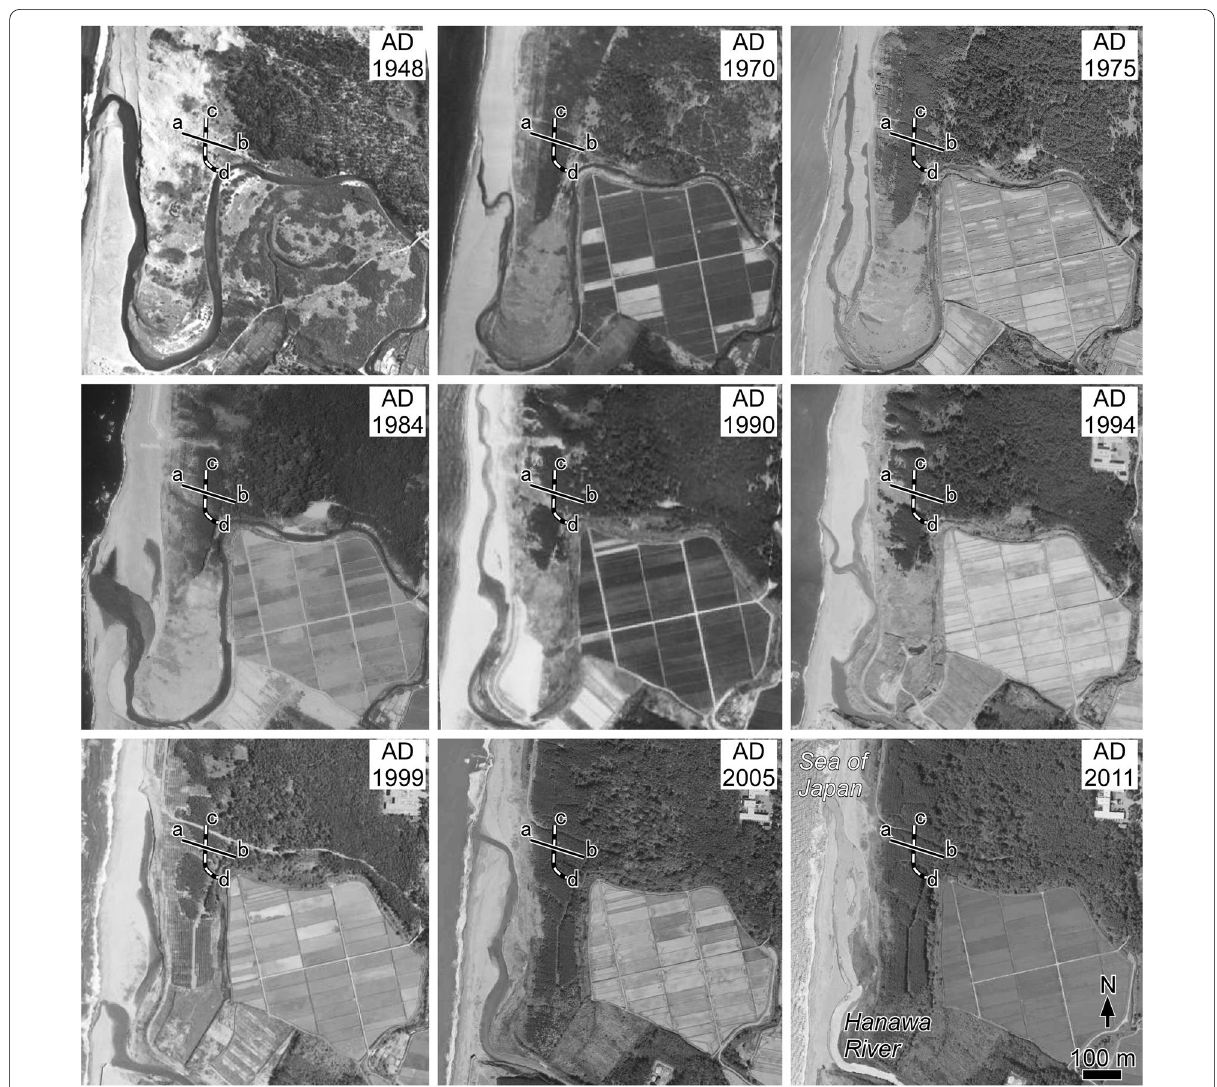
Fig. 2 History of topographic and land-use changes around Shimo-Katchikidai on the northern Akita coast, based on aerial photographs taken by the Geospatial Information Authority of Japan from 1948 to 2011 (Geospatial Information Authority of Japan 2022). The positions of the transects (a–b and c–d) shown in Fig. 3 are